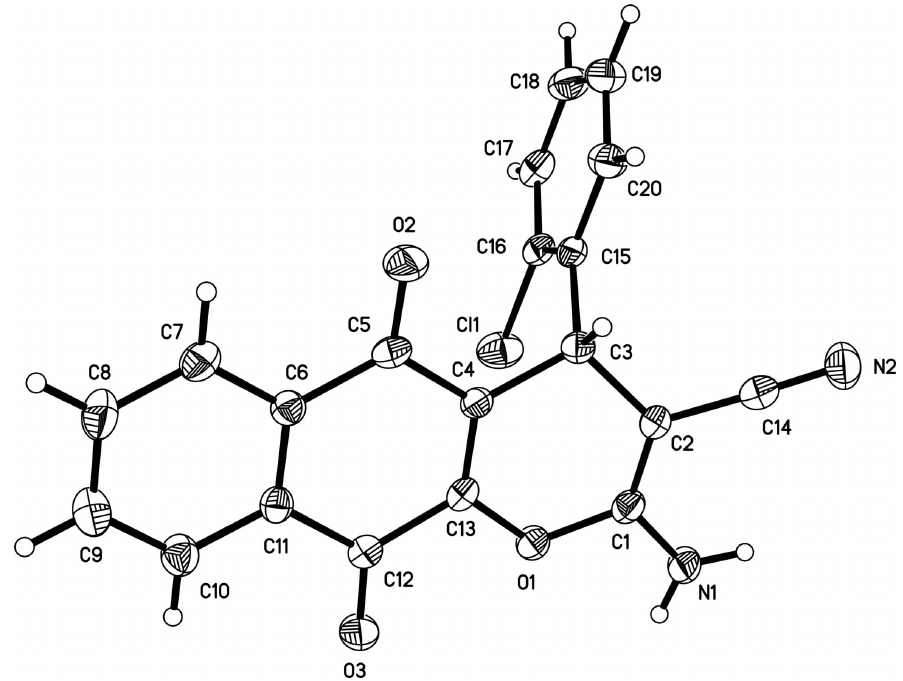
Figure 1 The molecular structure of the title molecule, with the atom-numbering scheme. Displacement ellipsoids are drawn at the 40% probability level.